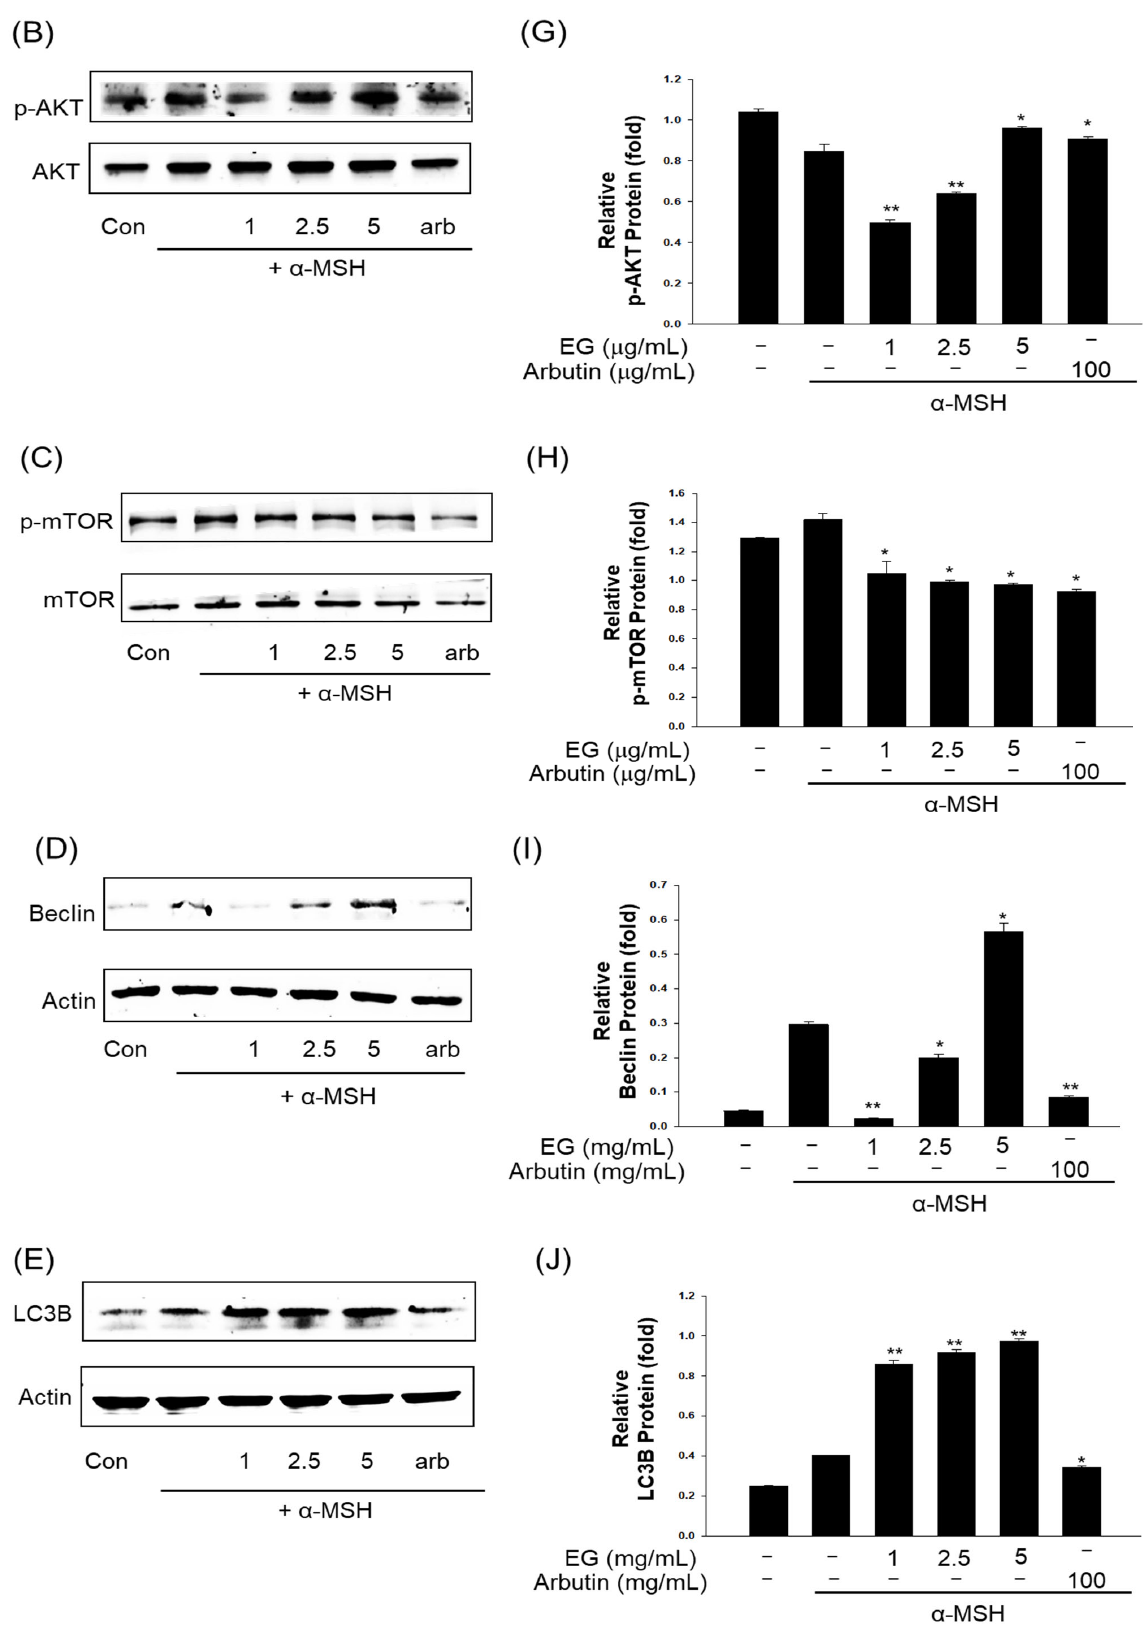
Figure 11. ( A ) Effect of EG and arbutin on AMP ‐ activated protein kinase (AMPK) protein expression in B16F10 melanoma cells. The cells were treated with the indicated concentrations of EG and arbutin prior to α‐ MSH treatment for 4 h. ( B ) Effect of EG and arbutin on phosphorylated AKT (p ‐ AKT) protein ex ‐ pression in B16F10 melanoma cells. The cells were treated with the indicated concentrations of EG and arbutin prior to α‐ MSH treatment for 4 h. ( C ) Effect of EG and arbutin on the phosphorylated mammalian target of rapamycin (p ‐ mTOR) and mTOR protein expression in B16F10 melanoma cells. The cells were treated with the indicated concentrations of EG and arbutin prior to α‐ MSH treatment for 4 h. ( D ) Effect of EG and arbutin on Beclin protein expression in B16F10 melanoma cells. The cells were treated with the indicated concentrations of EG and arbutin prior to α‐ MSH treatment for 4 h. ( E ) Effect of EG and arbutin on LC3B protein expression in B16F10 melanoma cells. The cells were treated with the indicated concen ‐ trations of EG and arbutin prior to α‐ MSH treatment for 4 h. ( F ) Quantitative analysis of AMPK by West ‐ ern blotting. ( G ) Quantitative analysis of p ‐ AKT by Western blotting. ( H ) Quantitative analysis of p ‐ mTOR and mTOR by Western blotting. ( I ) Quantitative analysis of Beclin by Western blotting. (J) Quan ‐ titative analysis of LC3B by Western blotting. * p < 0.05, ** p < 0.01, compared with α‐ MSH treatment.